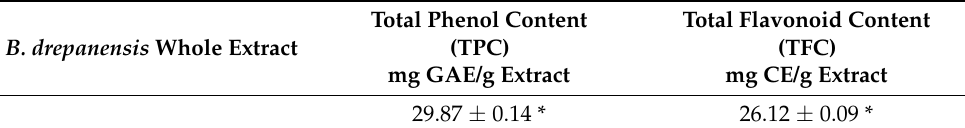
Table 3. Total phenol and flavonoid content of B. drepanensis whole extract.